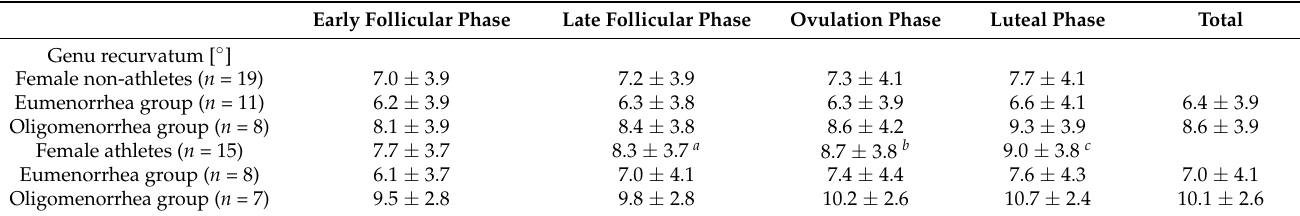
Table 5. Changes in genu recurvatum during the menstrual